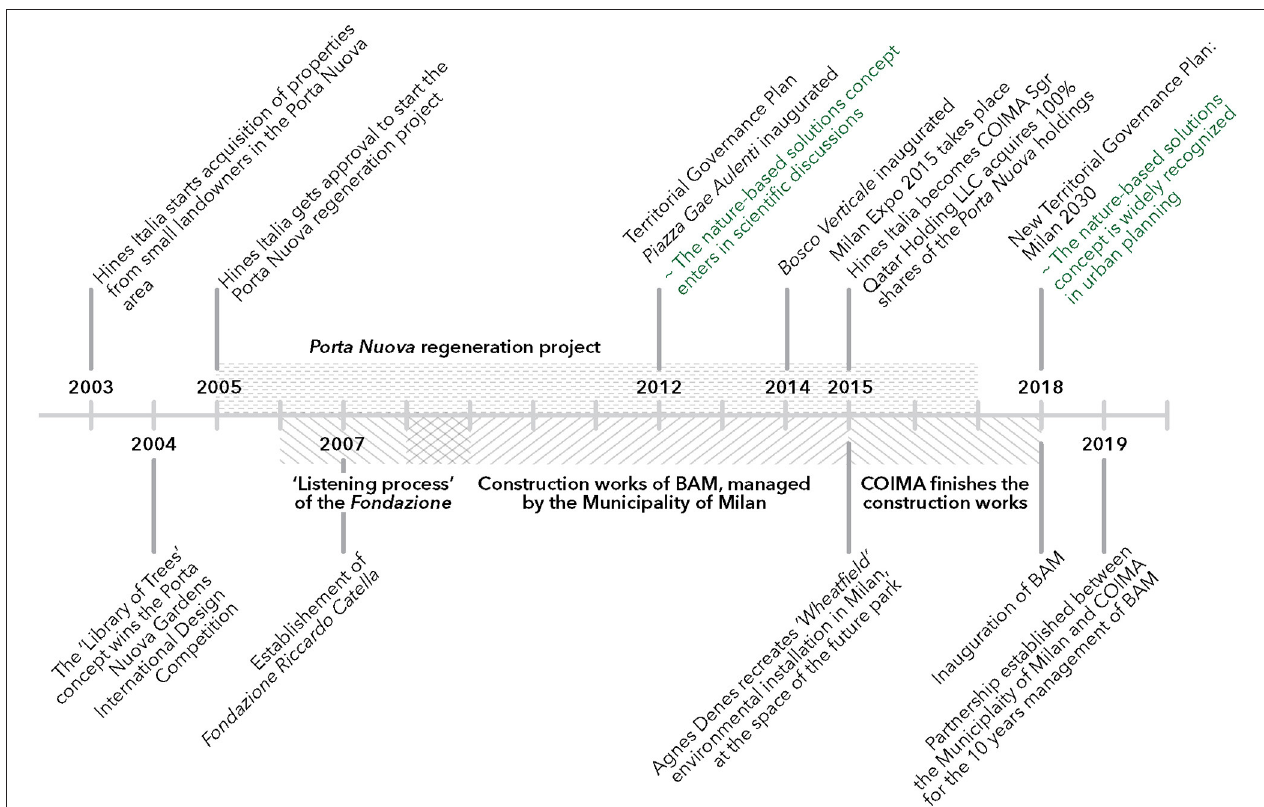
FIGURE 3 | Development timeline of Porta Nuova and